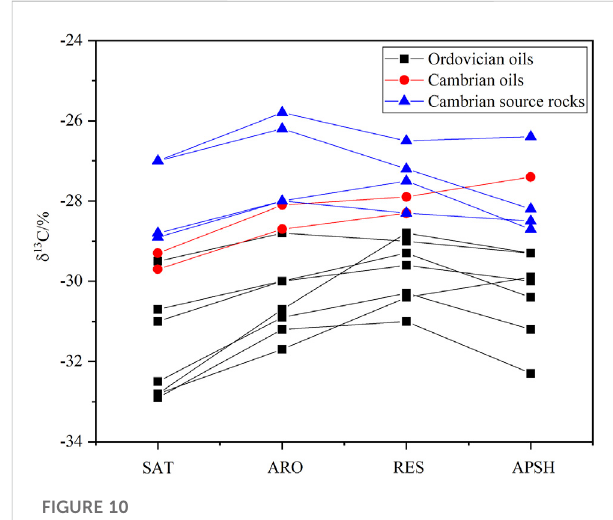
FIGURE 9 Carbon isotopic series of alkane gas in the Tarim Basin.